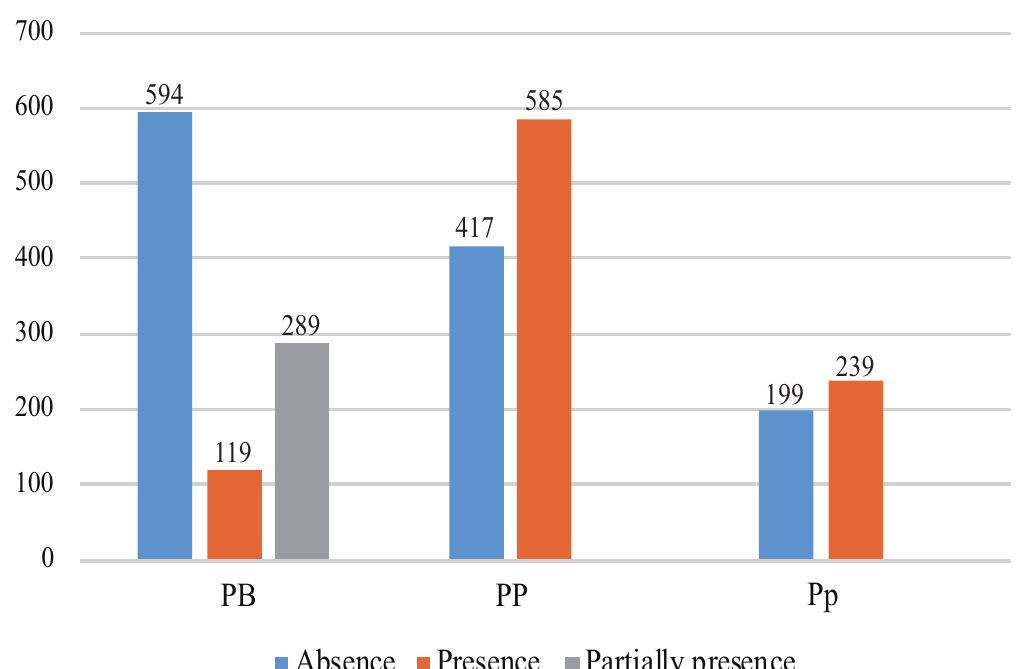
The condition of indumentum in piliferous blade (PB), piliferous petiole (PP) and piliferous pedicel (Pp).